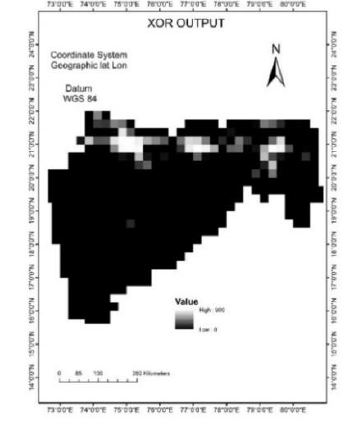
Figure 12. SPI map of October 2000 was compared with Figure 13.XOR